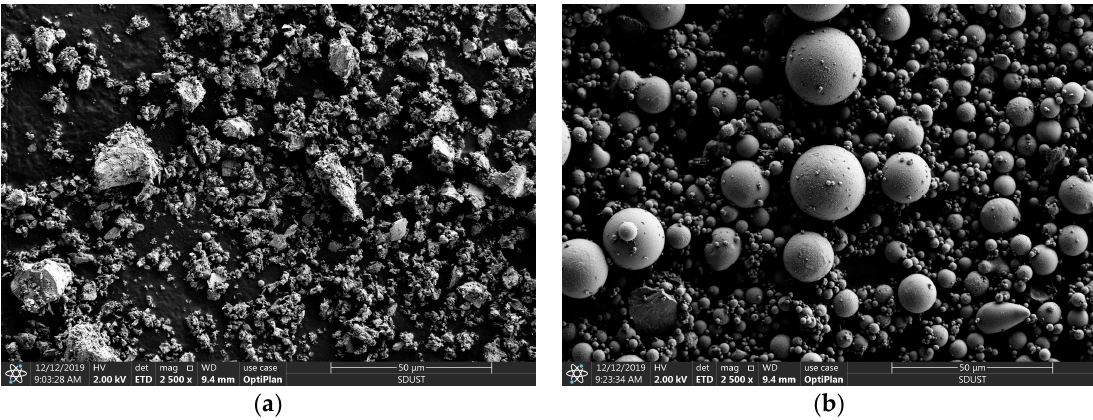
Figure 2. SEM photographs of the UC and UFA: ( a ) UC; ( b ) UFA.